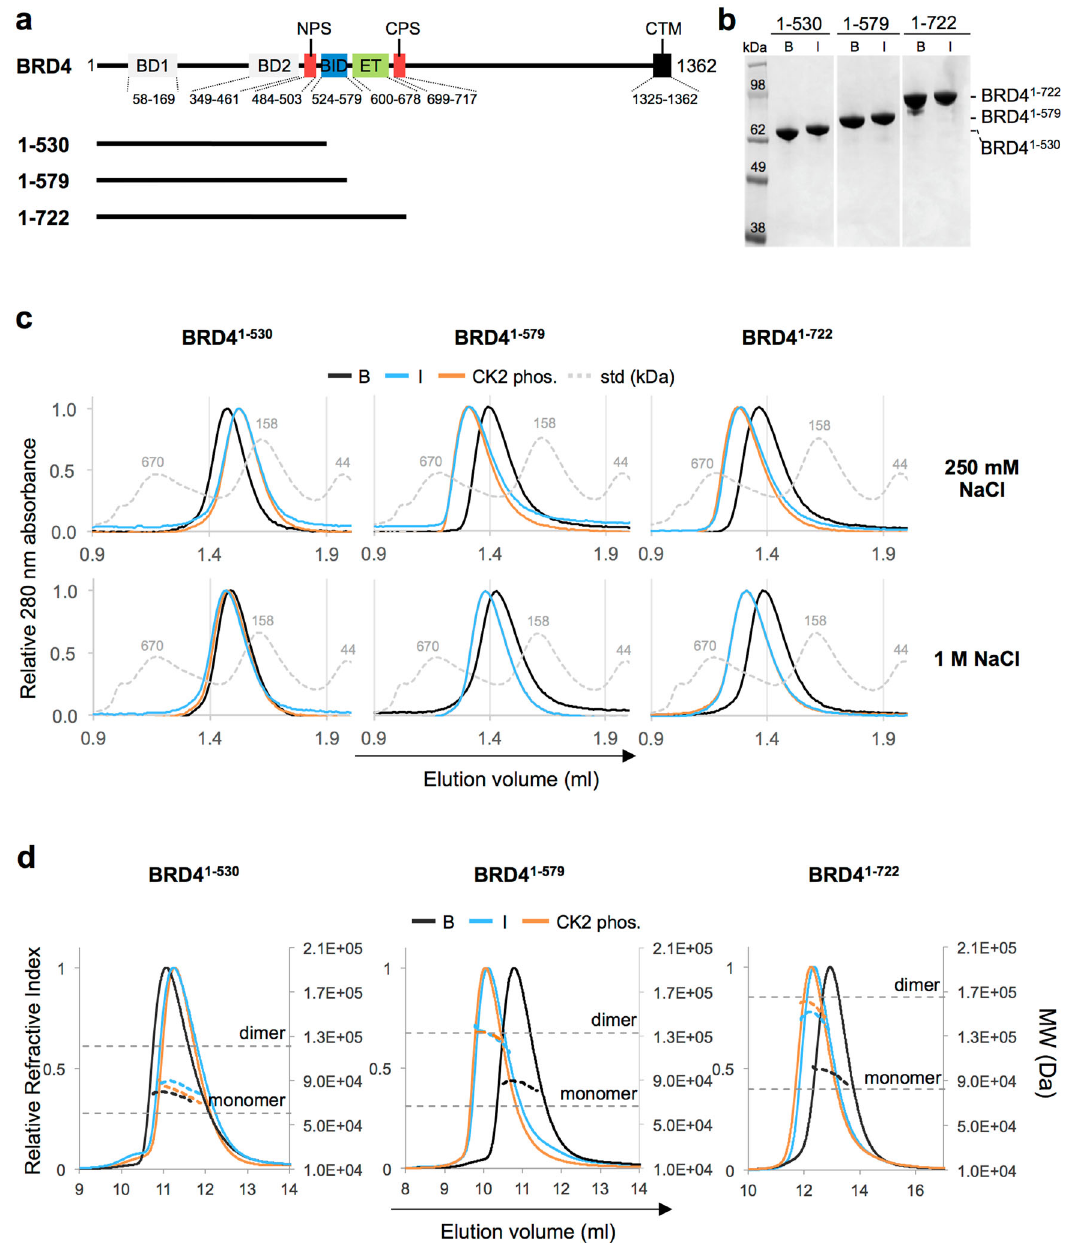
Fig. 1 Dimerization of BRD4 constructs containing BID upon CK2 phosphorylation. a Summary of the BRD4 constructs used in the study. A schematic representation of full-length BRD4 (long isoform A) and known regions is reported. b Coomassie-stained SDS-PAGE gel showing the purity of the recombinantly produced BRD4 constructs 1-530, 1-579, 1-722. c Elution pro fi les of analytical size-exclusion chromatography (SEC) performed with 20 µ M of the indicated constructs in the presence of 250 mM NaCl or 1 M NaCl. Std: Gel fi ltration standards (Bio-Rad) analysed in the corresponding low or high salt running buffer. d Elution pro fi les of the indicated constructs analysed by SEC-MALS. Samples are labeled as follows: black line indicates puri fi ed from bacteria, blue line indicates puri fi ed from insect cells, orange line indicates phosphorylated in vitro using CK2, dotted grey line in panels c , and d indicate protein molecular weight standards. The dotted line at each peak, colored as above, indicates the measured MW. The dotted horizontal grey lines in panel d represent the theoretical MW of the monomer or dimer of BRD4 1 – 530 , BRD4 1 – 579 , BRD4 1 – 722 , calculated from the primary